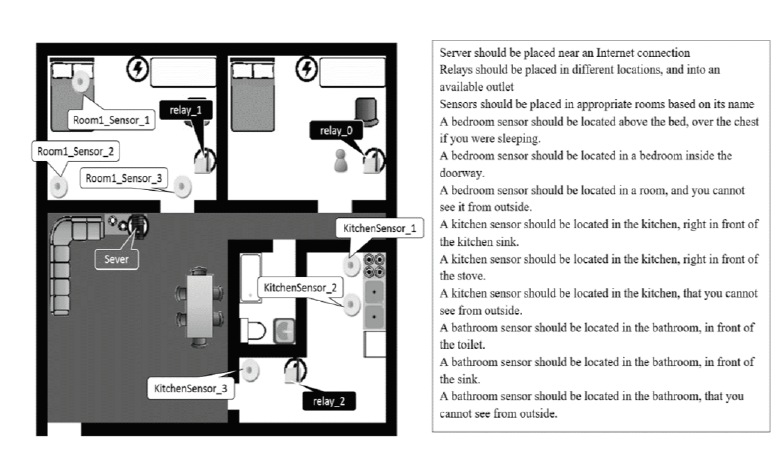
Figure 1. An example of a correct sensor placement for an apartment layout.